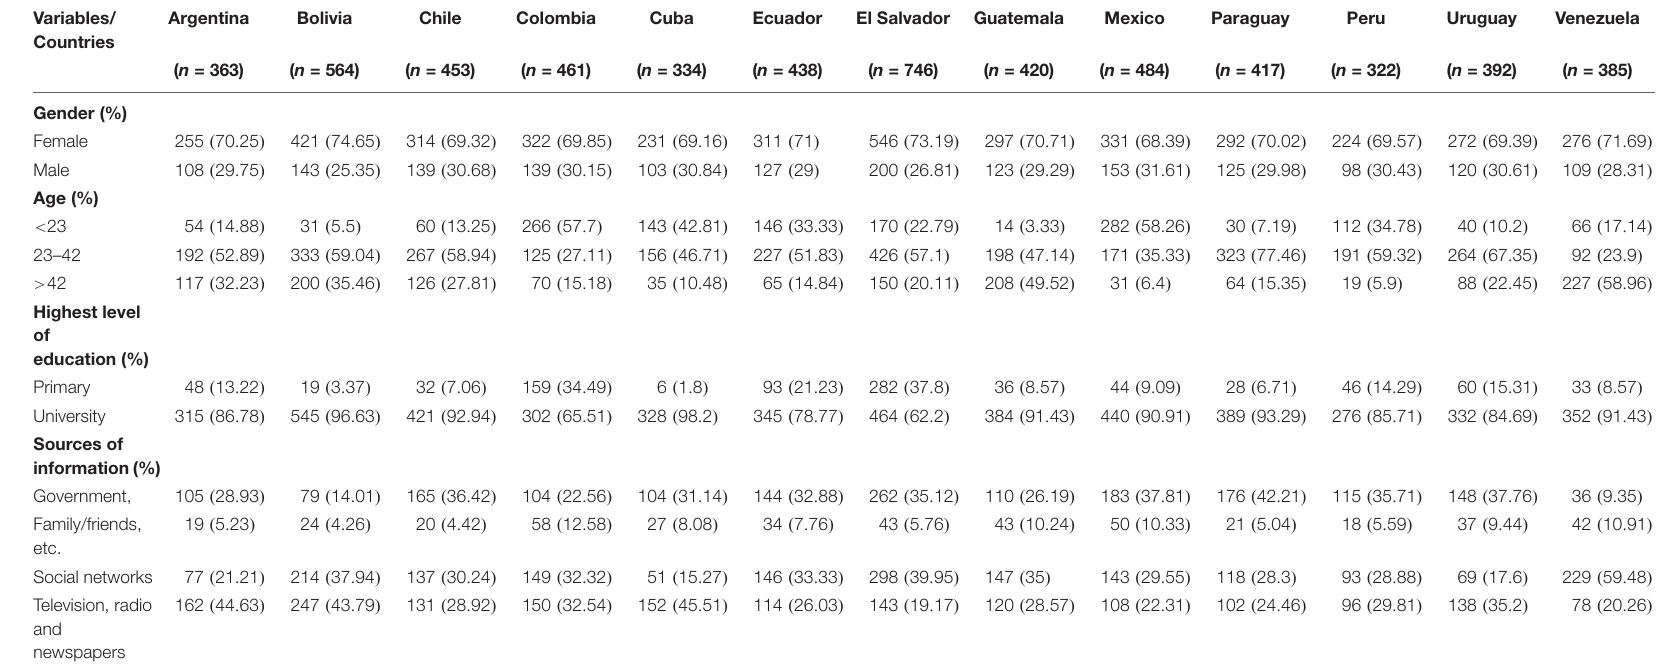
TABLE 1 | Sociodemographic information of the participants. Variables/ Countries